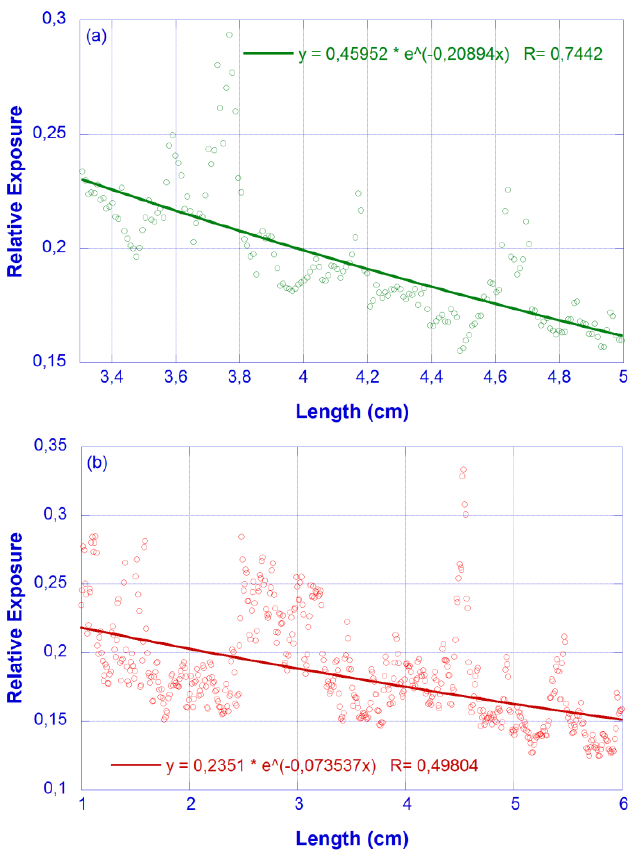
Figure 6. Relative exposure vs. X coordinate (photographic method). Feeding lasers: ( a ) λ = 532 nm (green, top); ( b ) λ = 632 nm (red, bottom). Dots: experimental values; Solid line: fit to an exponential decay.